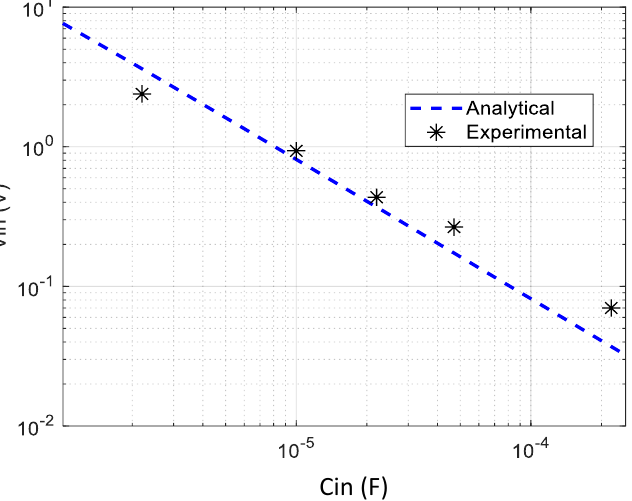
Figure 7. Effect of the storage capacitor ( C in ) on the storage voltage ( V in ) after 2 s; f = 3.3 Hz .